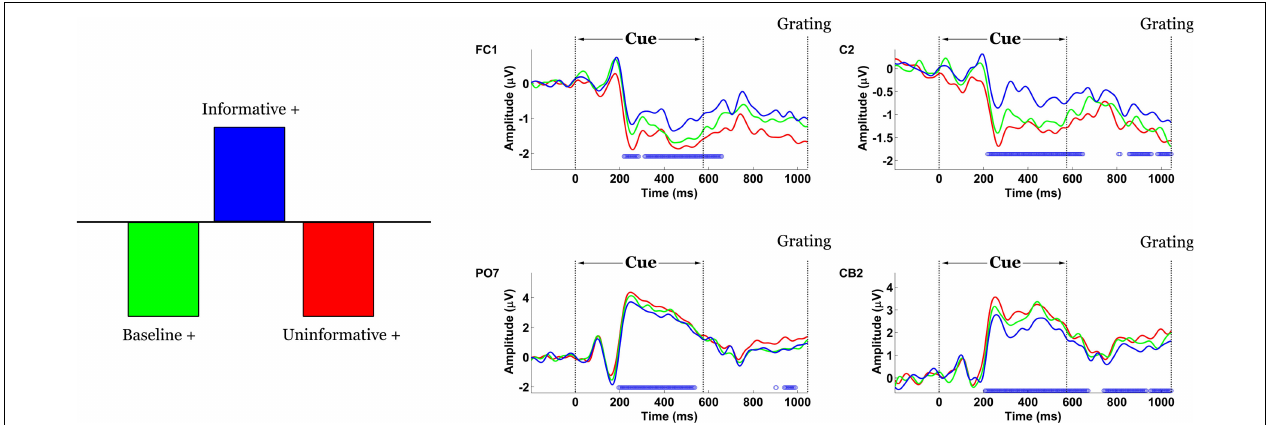
FIGURE 4 | Spatiotemporal patterns of scalp activity that differentiate Informative and Uninformative/Baseline conditions. Left: schematic indicates how the statistical contrast was coded. Right: condition-specifi c ERPs